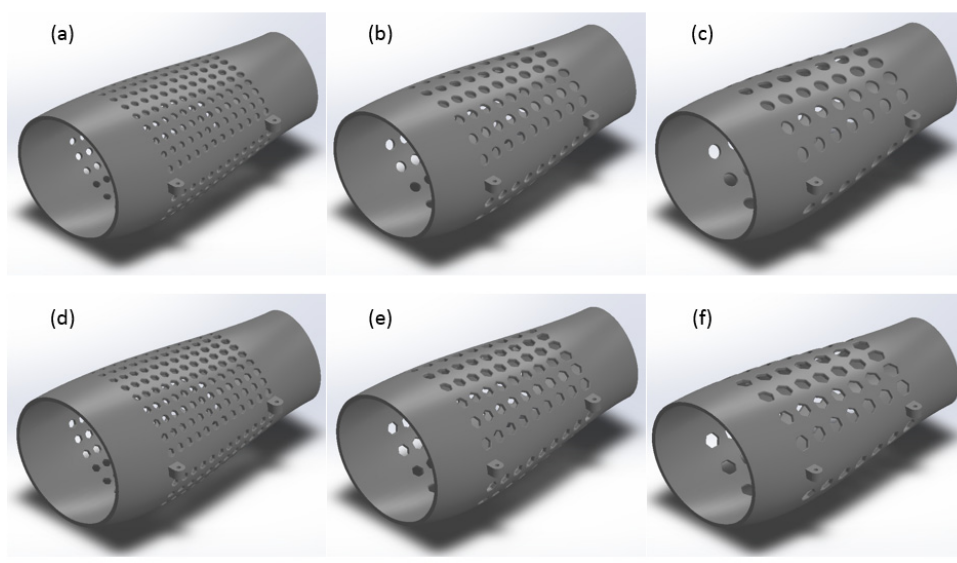
Figure 4. ( a ) Circular design with 7 mm diameter, ( b ) 10 mm diameter, and ( c ) 13 mm diameter; and ( d ) hexagonal design with 7 mm diameter, ( e ) 10 mm diameter, and ( f ) 13 mm diameter.